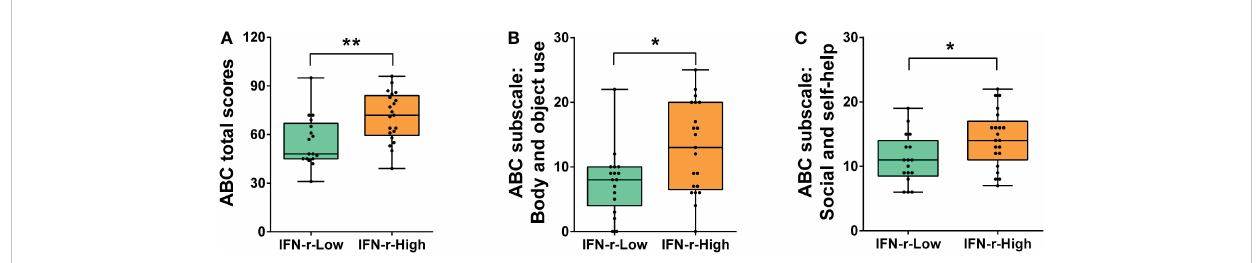
FIGURE 1 Differences of ABC total and subscales scores between the IFN- g -Low and IFN- g -High groups. (A) ABC total scores; (B) Scores of ABC subscale III: Body and object use; (C) Scores of ABC subscale V: Social and self-help. The horizontal line and the box indicate the median and the interquartile range (IQR), and the whisker spans the minimum to maximum. * p <0.05, ** p <0.01.